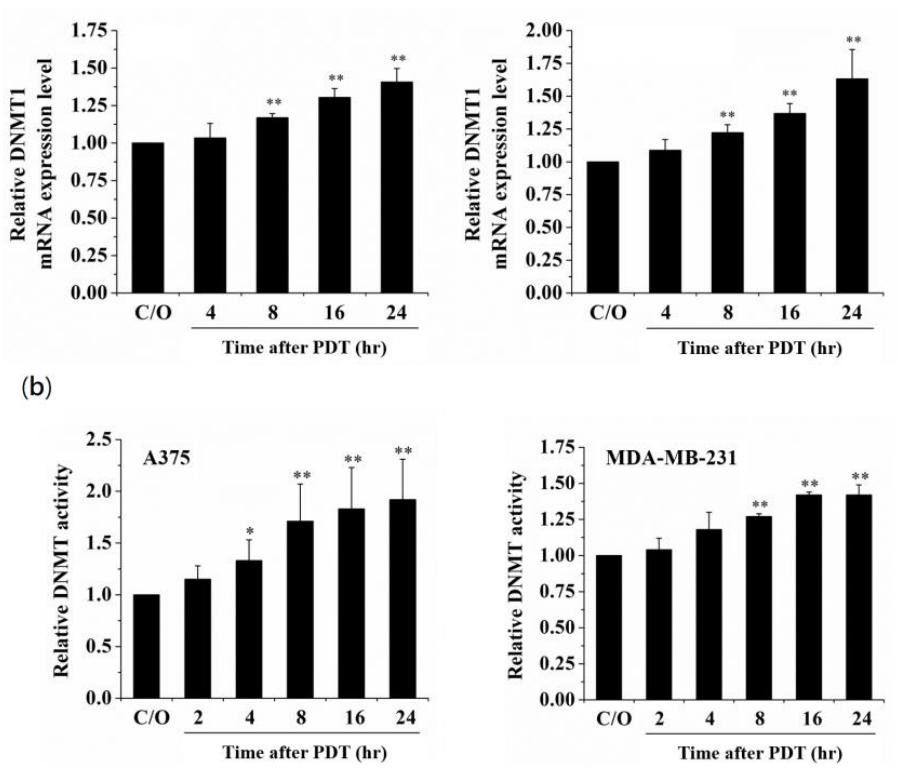
Figure 2. Increase of mRNA expression level and enzymatic activity of DNMT1 in PDT-treated cancer cells. ( a ) RT-PCR was performed to analyze the mRNA expression level of DNMT1 in A375 (left panel) and MDA-MB-231 (right panel) cells at the time indicated after ALA-PDT. The light dose for A375 and MDA-MB-231 cells is 2 J/cm 2 and 4 J/cm 2 , respectively. The relative mRNA expression level of each gene was measured by RT-PCR and normalized to β -actin. The same volume of each PCR product was loaded, and band blots for each gene were cropped from different gels; ( b ) Nuclear protein samples were extracted from PDT-treated cells. 5 µ g protein of each sample was used for analyzing the DNMT activity assay. The control group was cells only treated with ALA w/o light irradiation. Data represent from three independent experiments. Each bar shown is the mean fold change relative to control ± SD. Results are considered to be statistically significant at * p < 0.05 and ** p < 0.01.